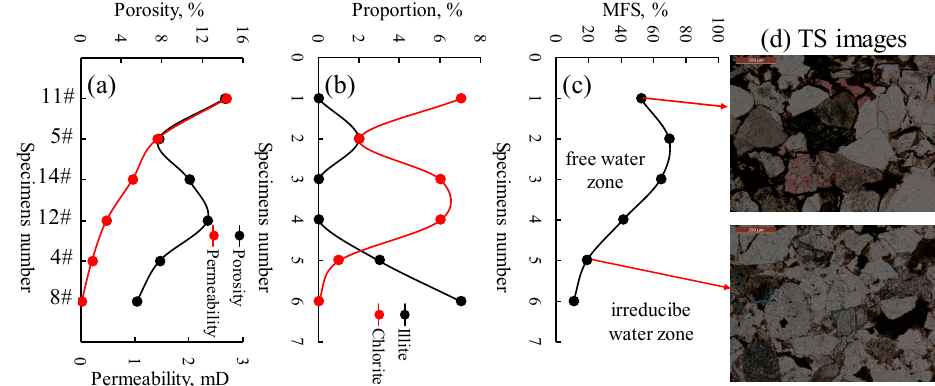
Figure 16. Graphs illustrating the impacts of pore types, movable fluid saturation and clay mineral contents on reservoir quality. ( a ) reservoir quality; ( b ) clay minerals; ( c ) movable fluid saturations (MFS); ( d ) thin section images record the pore types.